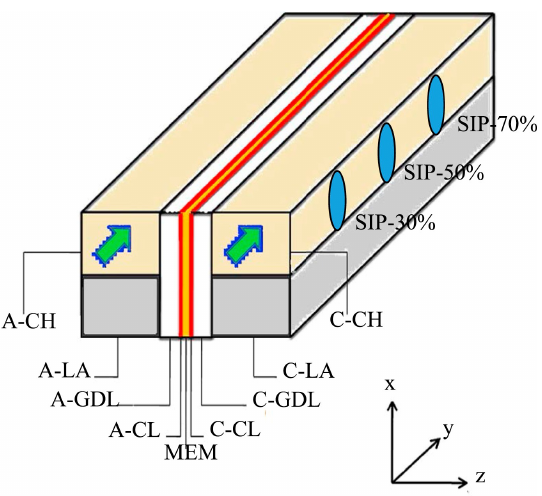
Figure 23. The schematic diagram of a PEMFC channel having sub-channels